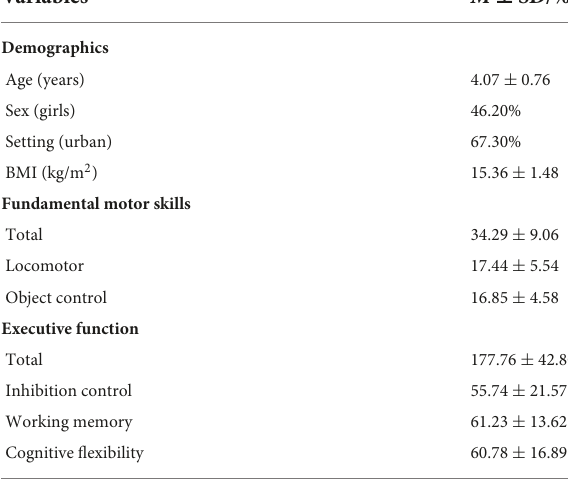
TABLE 1 Descriptive statistics of study